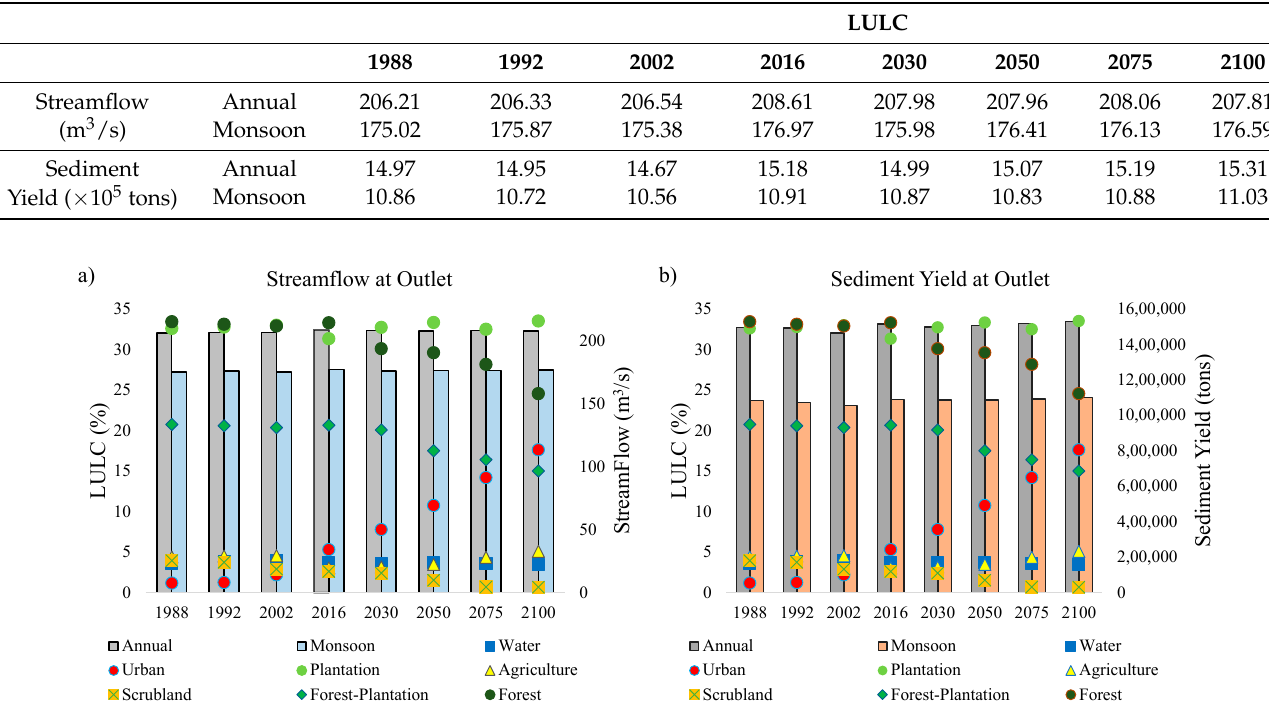
Figure 5. Annual and monsoon season ( a ) streamflow and ( b ) sediment yield at the outlet (sub- watershed 8) with varying LULC between 1988 and 2100. Note: most of the changes in urban area occurred in the region downstream of watershed #8, so a direct impact of urban on SF and SY is not visible.